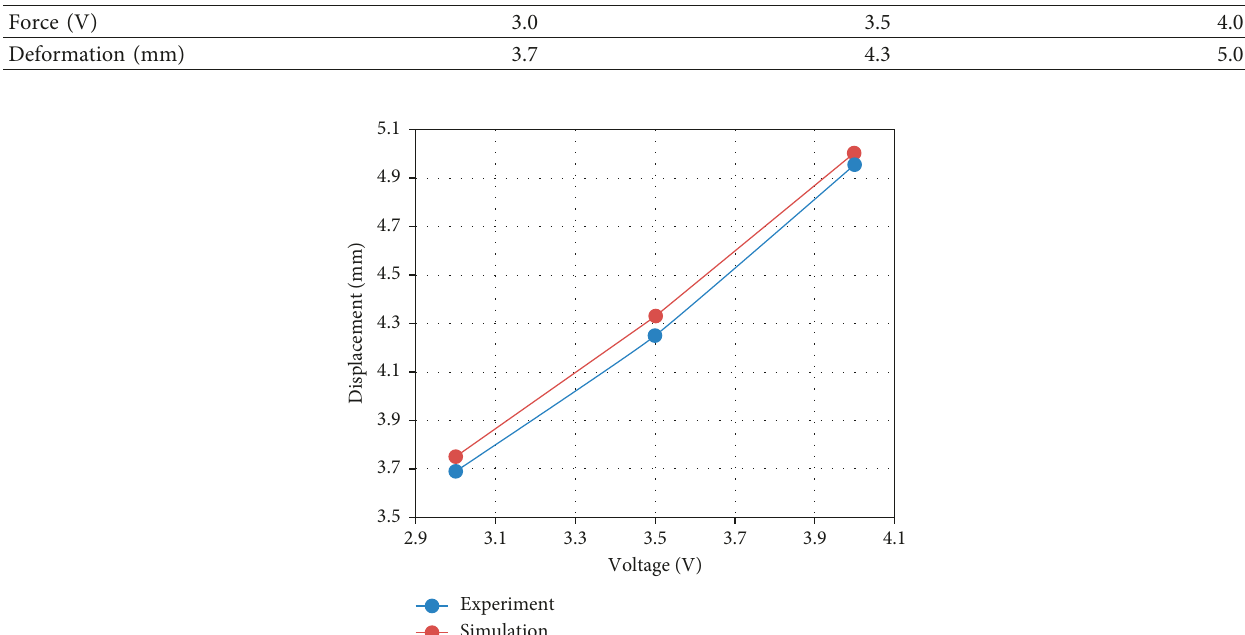
Table 2: Displacement calculation results for the different input voltages.